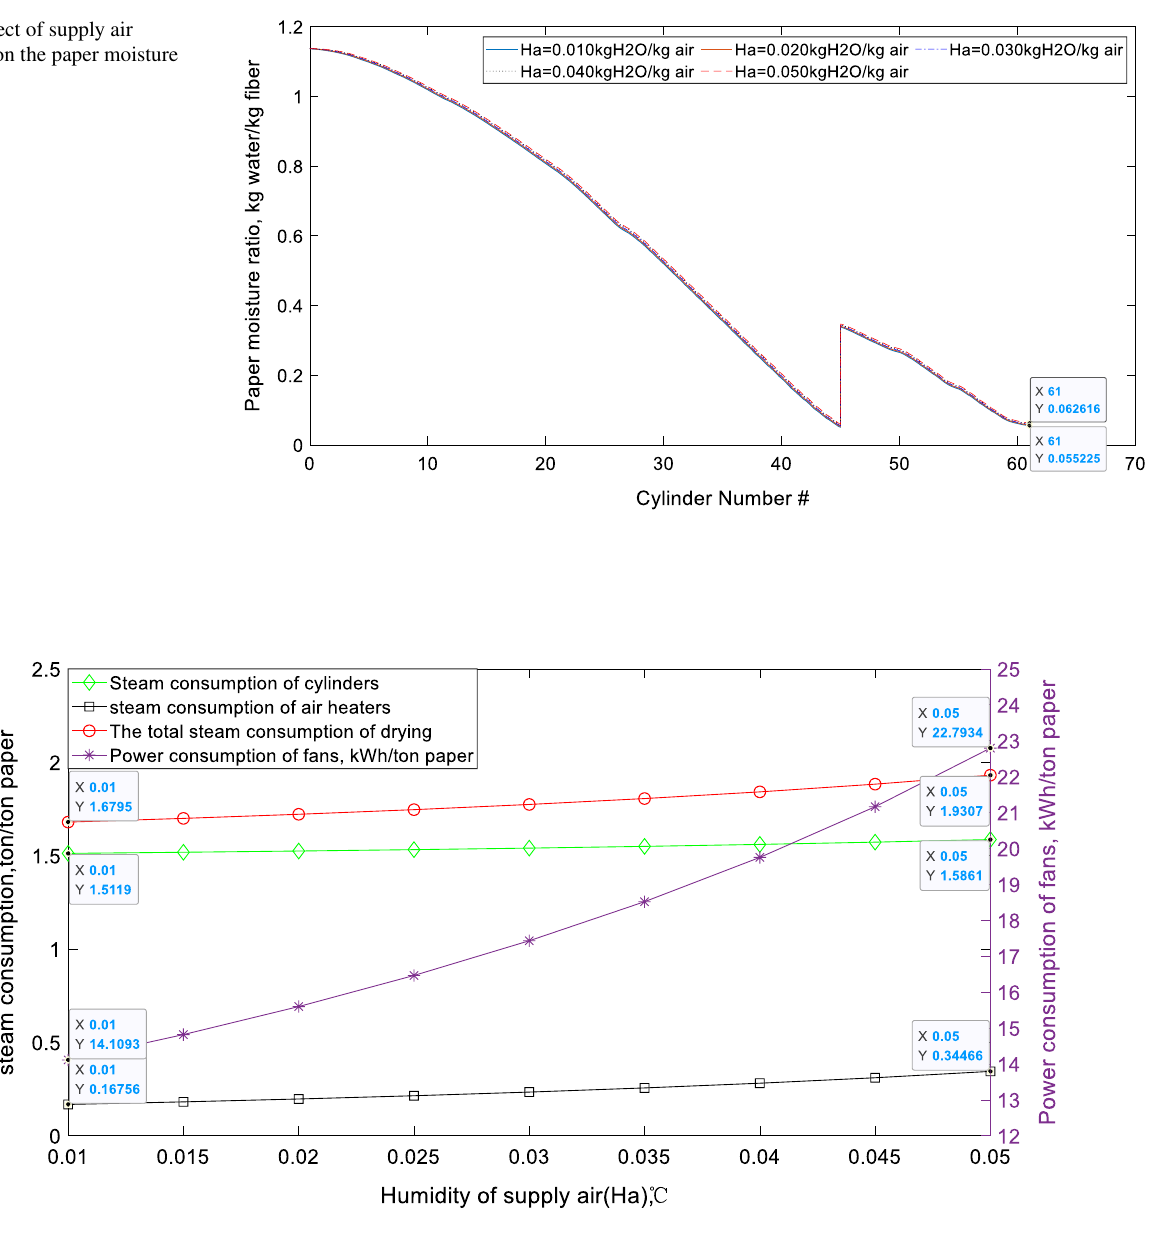
Fig. 10 Effect of air humidity on the energy consumption of drying